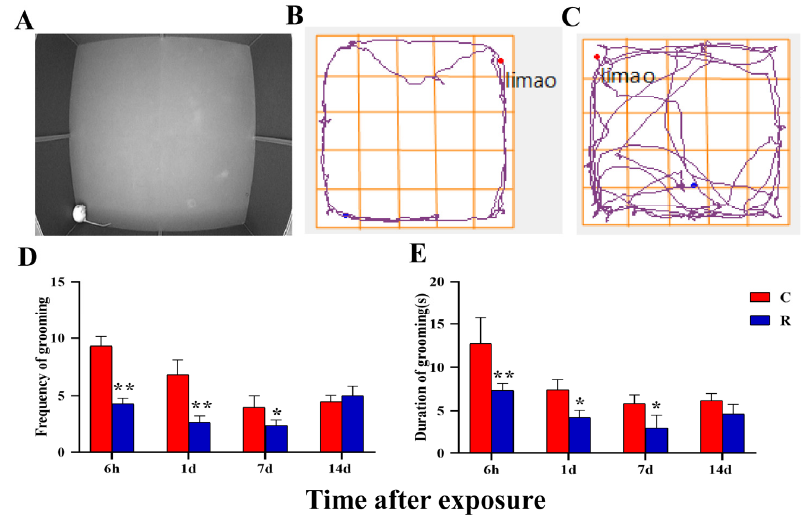
Figure 11. Changes in the open field experiment of rats after S-band radiation—grooming behavior. ( A ) The real shot of the rat when grooming; ( B ) the trajectory diagram of the Group R; ( C ) the trajectory diagram of the Group C; ( D ) statistical analysis graph of grooming frequency; ( E ) statistical analysis graph of grooming duration. Significance signs were classified according to p -value: * p < 0.05 and ** p < 0.01.